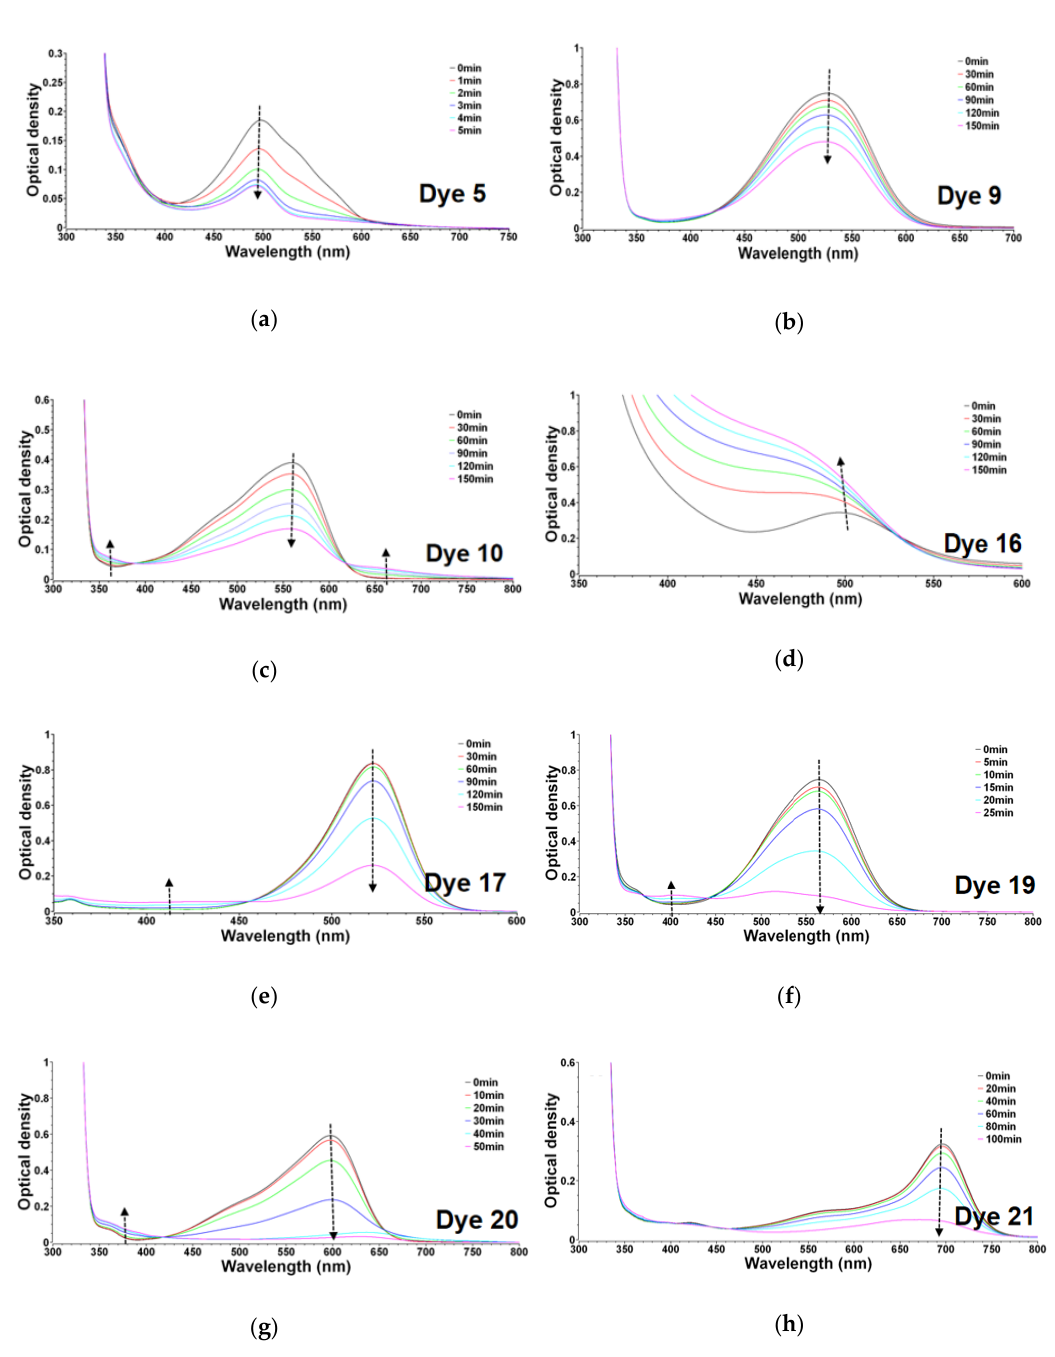
Figure 3. UV-visible absorption spectra of di ff erent dyes with co-initiators: iodonium salt (Speedcure 938, 1.46 × 10 − 4 M) and amine (Speedcure EDB, 4.07 × 10 − 4 M) upon exposure to LED@405nm under air in acetonitrile: ( a ) dye 5 (1.04 × 10 − 5 M), ( b ) dye 9 (1.30 × 10 − 5 M), ( c ) dye 10 (9.31 × 10 − 6 M), ( d ) dye 16 (6.46 × 10 − 6 M), ( e ) dye 17 (9.20 × 10 − 6 M), ( f ) dye 19 (1.11 × 10 − 5 M), ( g ) dye 20 (8.33 × 10 − 6 M), ( h ) dye 21 (7.56 × 10 − 6